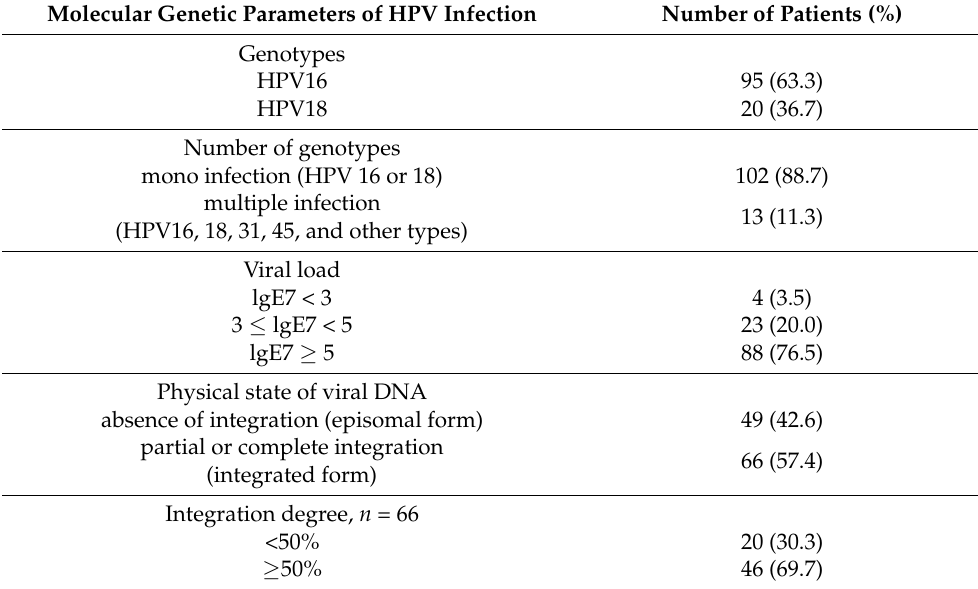
Table 2. Molecular genetic parameters of HPV infection in 115 HPV16/18-positive patients with FIGO II-III